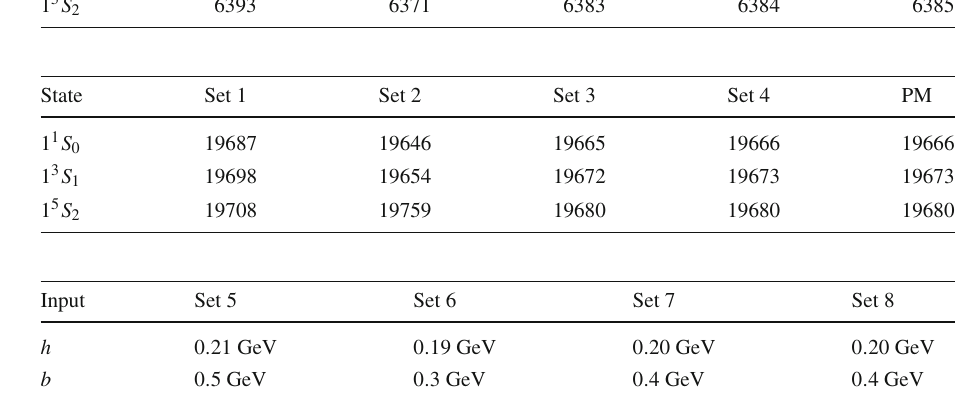
Table 11 Responses in cc ¯ c ¯ c tetraquark mass values to potential parameter input in group 1. PM stands for results of potential model used in this work. All results are in MeV